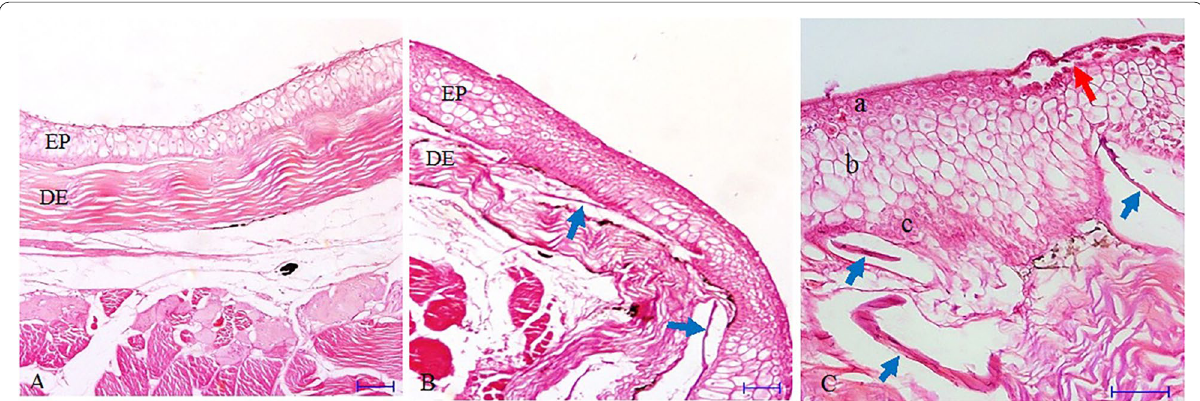
Fig. 1 Microscopic structure of skin in P. waltoni (5 μm section, Hematoxylin-Eosin staining). A Ventral skin (Scale bar 50 μm), B Dorsal skin (Scale bar 50 μm), C Dorsal skin (Scale bar 20 μm). (EP): Epidermis, (DE): Dermis, a Stratum germinativum, b Middle layer, c Superficial layer, Red arrow: Blood capillary, Blue arrow: Scale